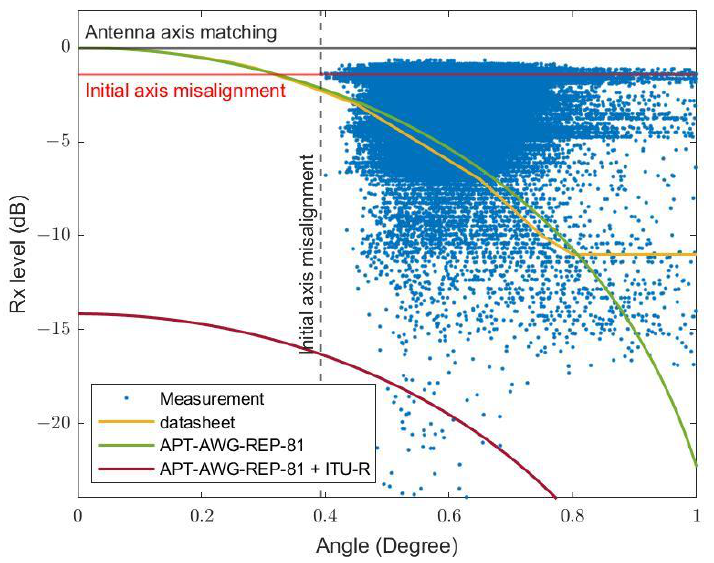
Figure 14. Minimum received signal versus inclination angle magnitude via direct measurement due to wind and rain.